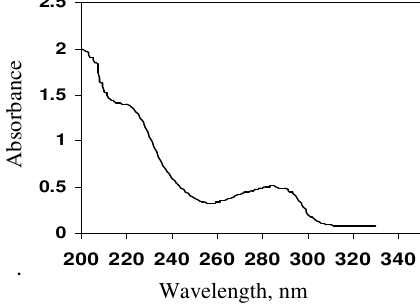
Figure 2. UV spectra of